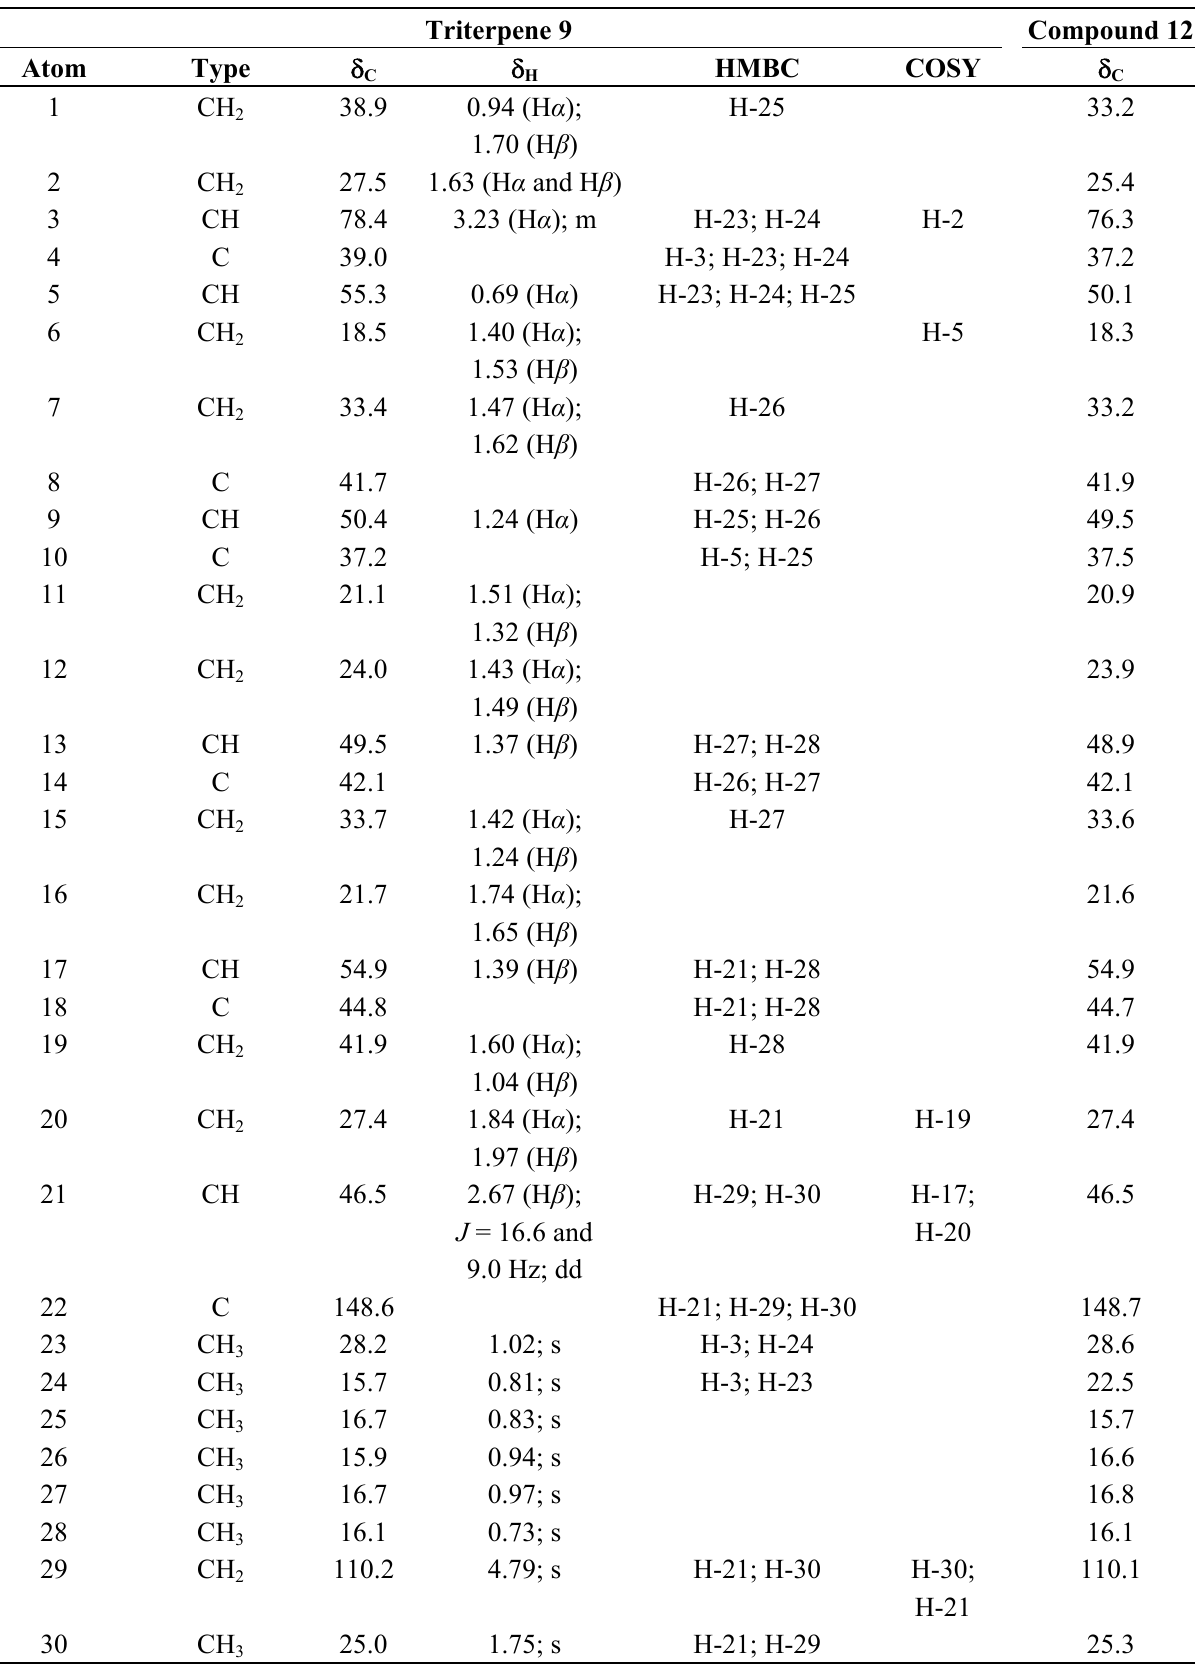
Table 3. NMR data of triterpene 9 and corresponding data described in the literature for 12 [26]. Triterpene 9 Compound